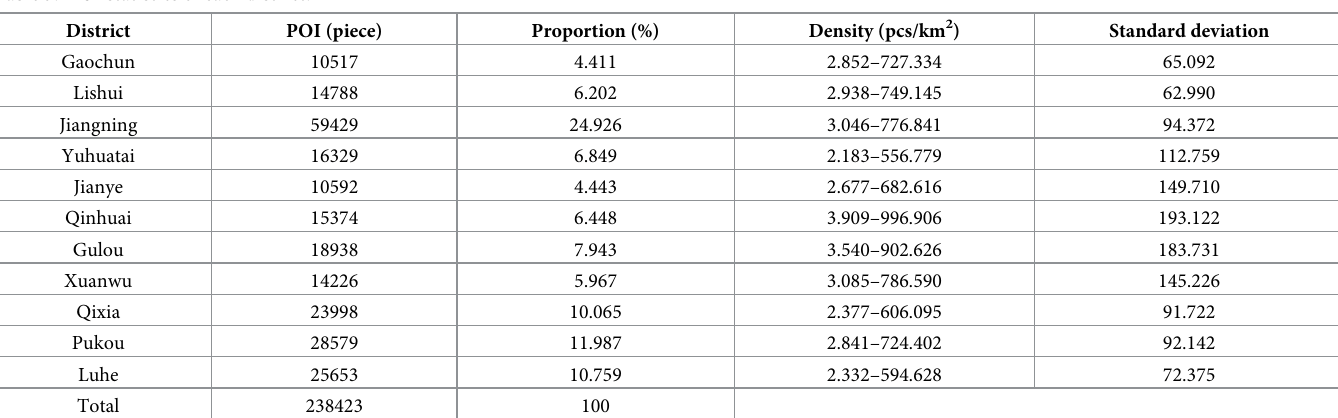
Table 5. POI statistics of each district.